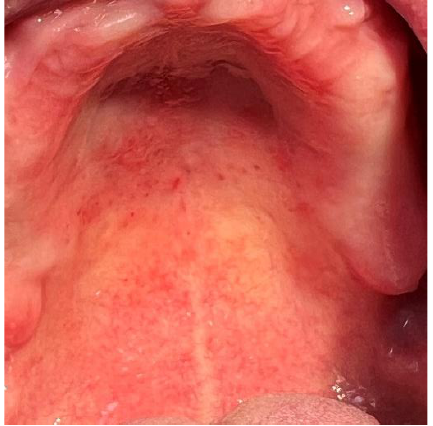
Figure 3. Denture stomatitis in the upper jaw.